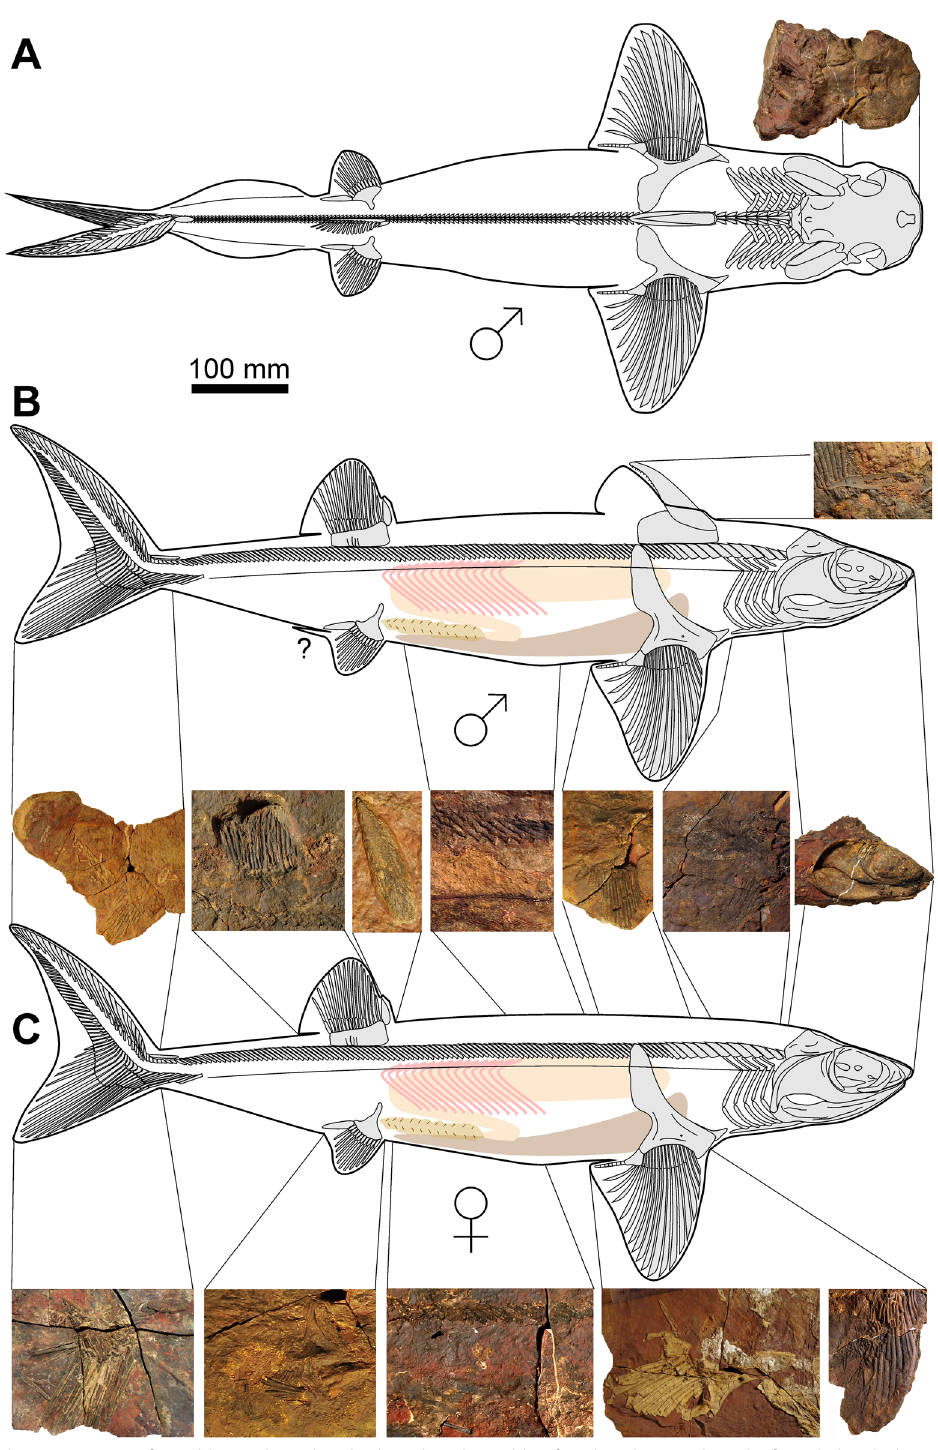
Fig. 11 Skeletal reconstruction of possibly a male ( A dorsal. B lateral) and possibly a female ( C bottom, lateral) of Maghriboselache mohamezanei n. gen. et sp. The according details were collected from the mentioned specimens. Note the presence of anterior dorsal fin spine in the supposed males, possibly serving a role during copulation. Claspers are not present in the supposed males of our sample. The photos show the according regions of specimens displayed in Fig. 1 and the Additional file